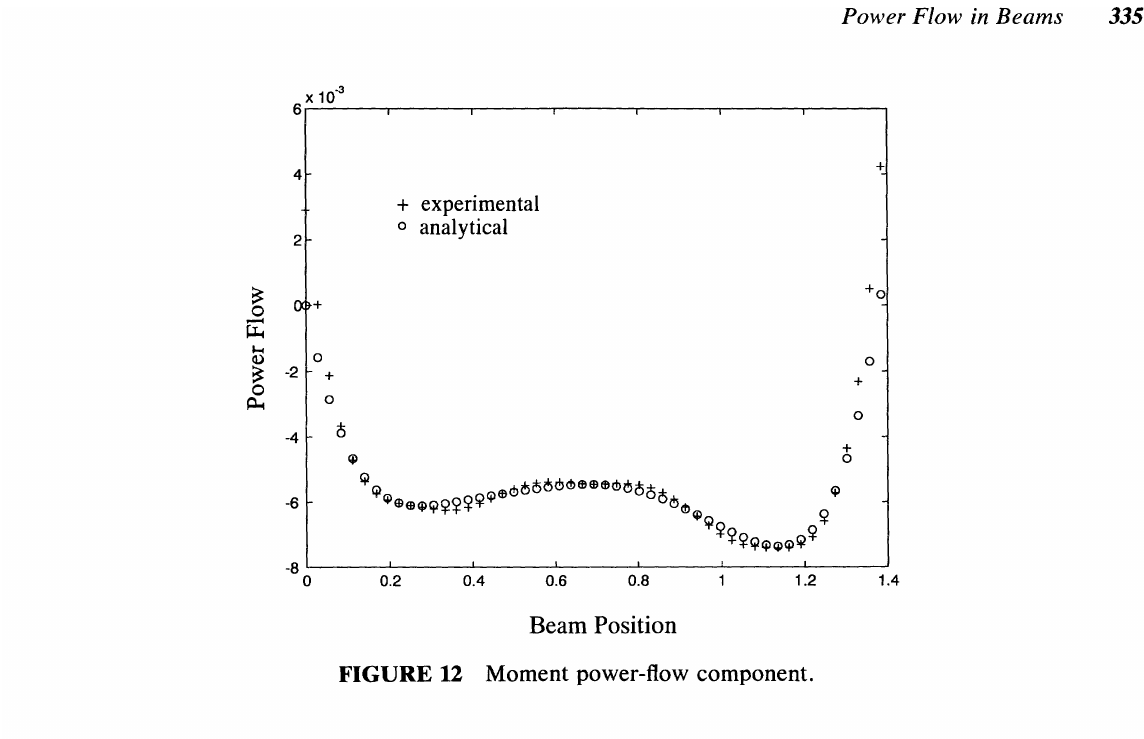
FIGURE 12 Moment power-flow component.